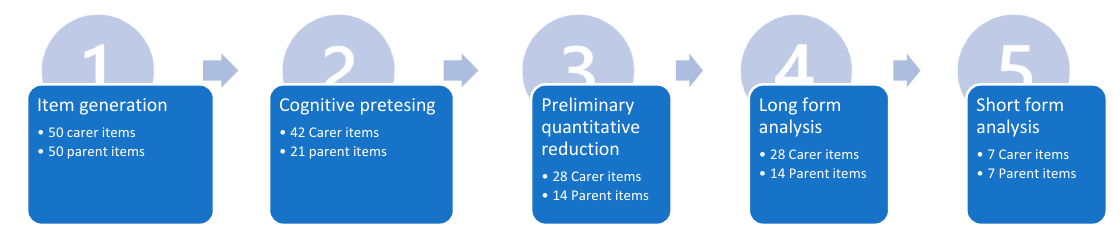
Figure 1. Protocol stages from item generation to short form analysis of FACS long and short form instruments.